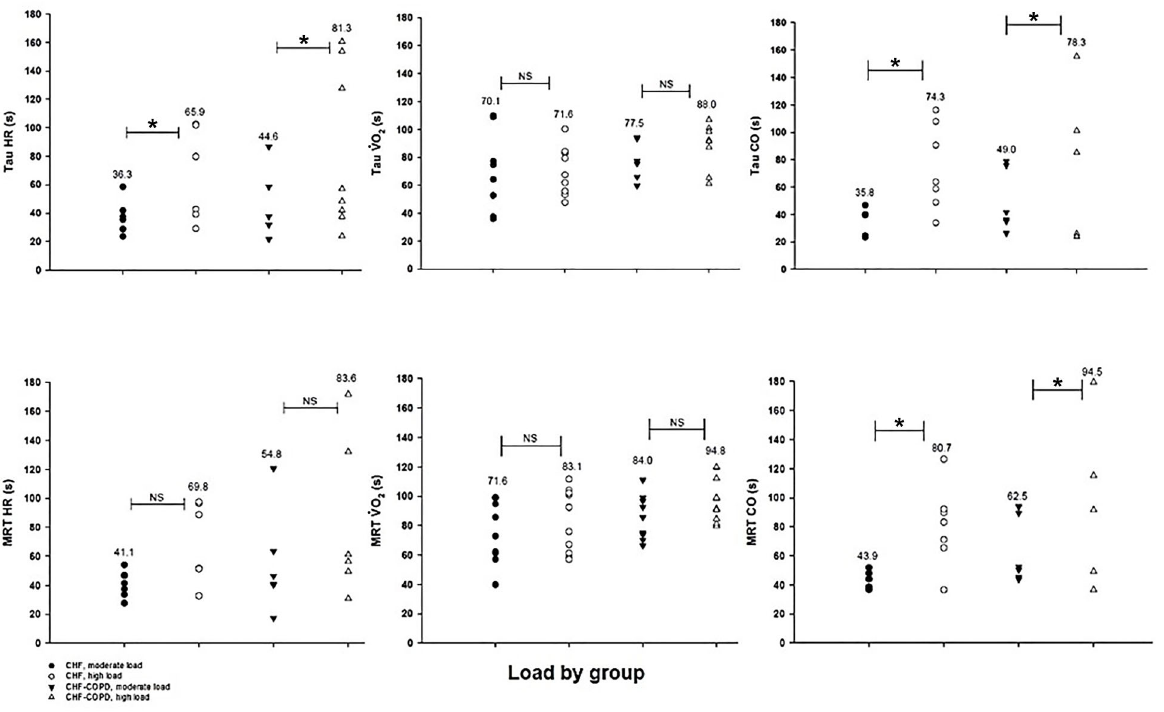
. Figure 2. Heart rate (HR), oxygen uptake ( VO 2 ), and cardiac output (CO) off-kinetics variables at moderate and high constant-load exercise test in chronic heart failure (CHF) and CHF-chronic obstructive pulmonary disease (COPD) groups. MRT: mean response time; Tau: time constant; NS: not signi fi cant. *P o 0.05 (ANOVA) (n=6 – 8 per